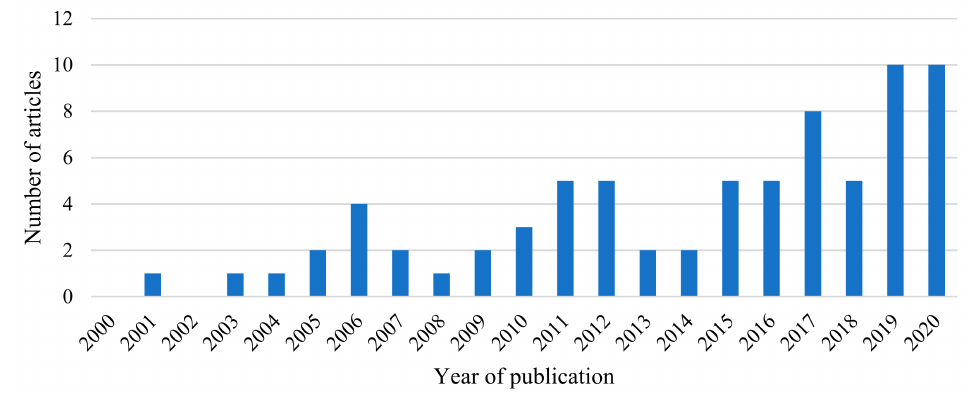
Figure 3. Publication date, distribution of reference